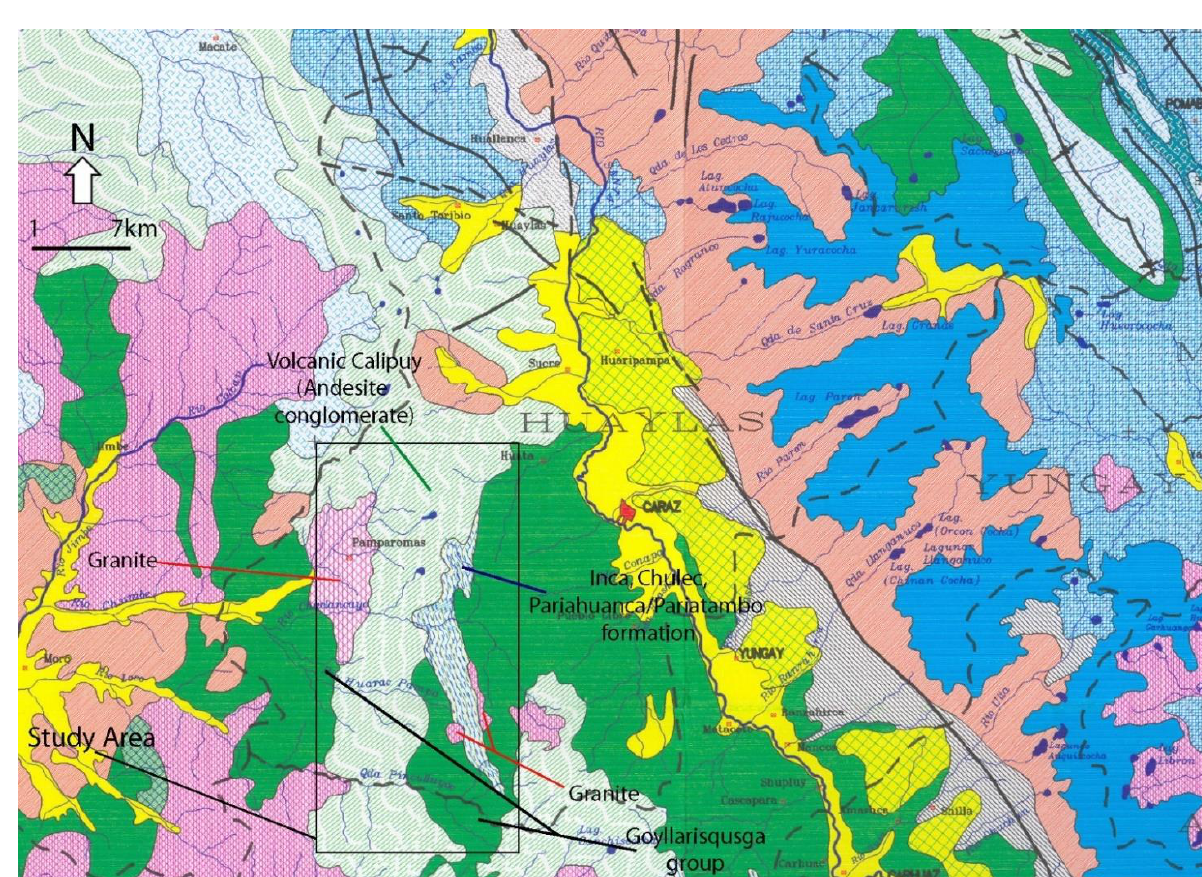
Figure 2. Geology of the study area showing the main groups, formations, and types [67].